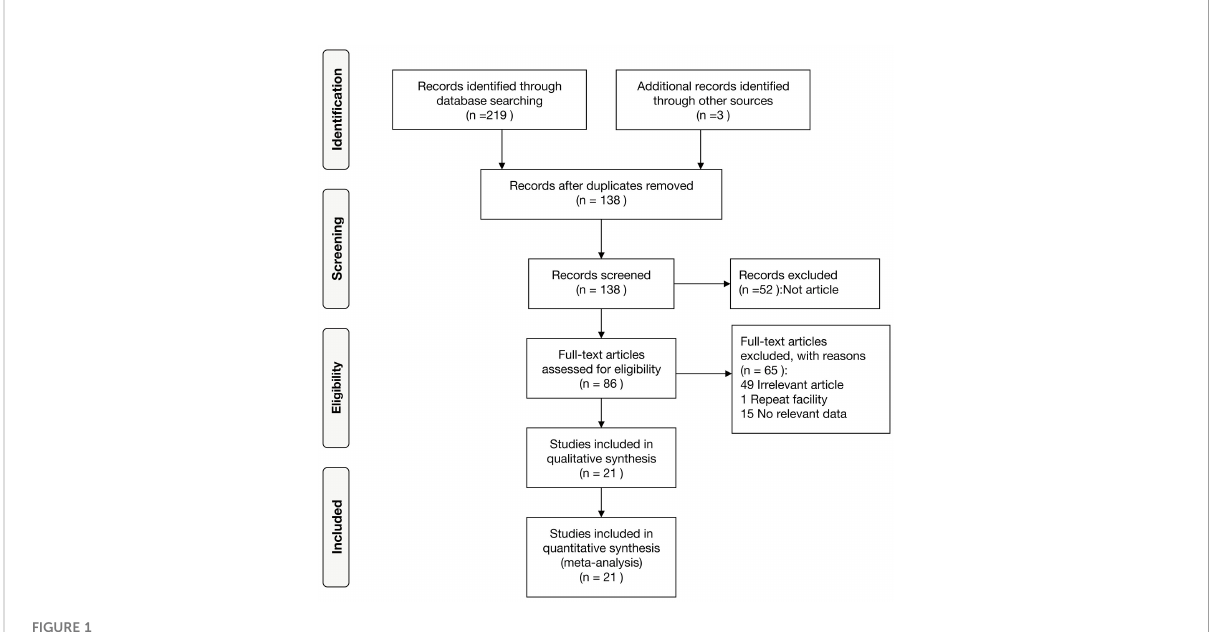
FIGURE 1 Flow diagram of the selection of the included